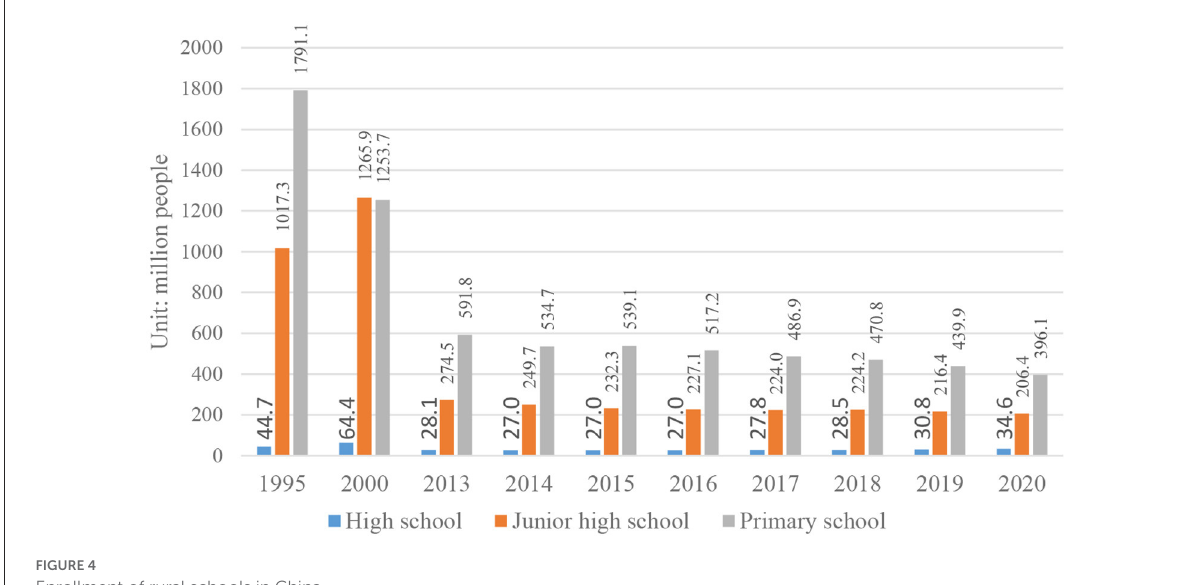
FIGURE4 Enrollment of rural schools in